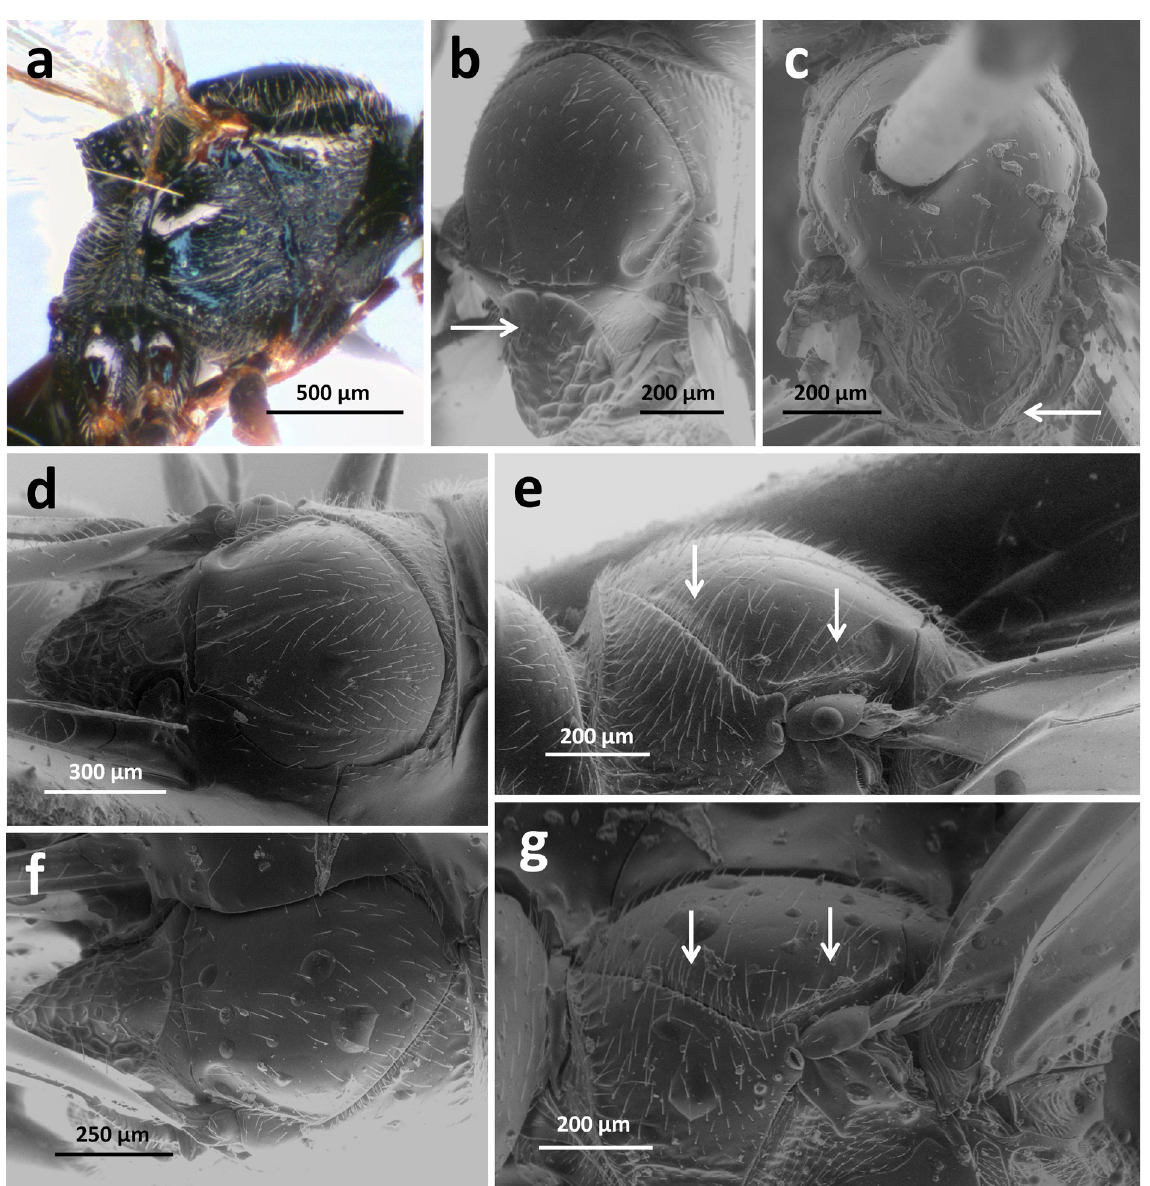
Fig. 3. a . Aegilips ustulatus Belizin, 1973, mesosoma in lateral view. b . A. longicellus Belizin, 1951, mesosoma in dorsal-lateral view. c . A. flavidicornis (Kieffer, 1911), mesosoma in dorsal view. d . A. atricornis Fergusson, 1985, mesosoma in dorsal view. e . A. atricornis , mesoscutum in lateral view. f . A. paucus Belizin, 1961, mesosoma in dorsal view. g . A. paucus , mesoscutum in lateral